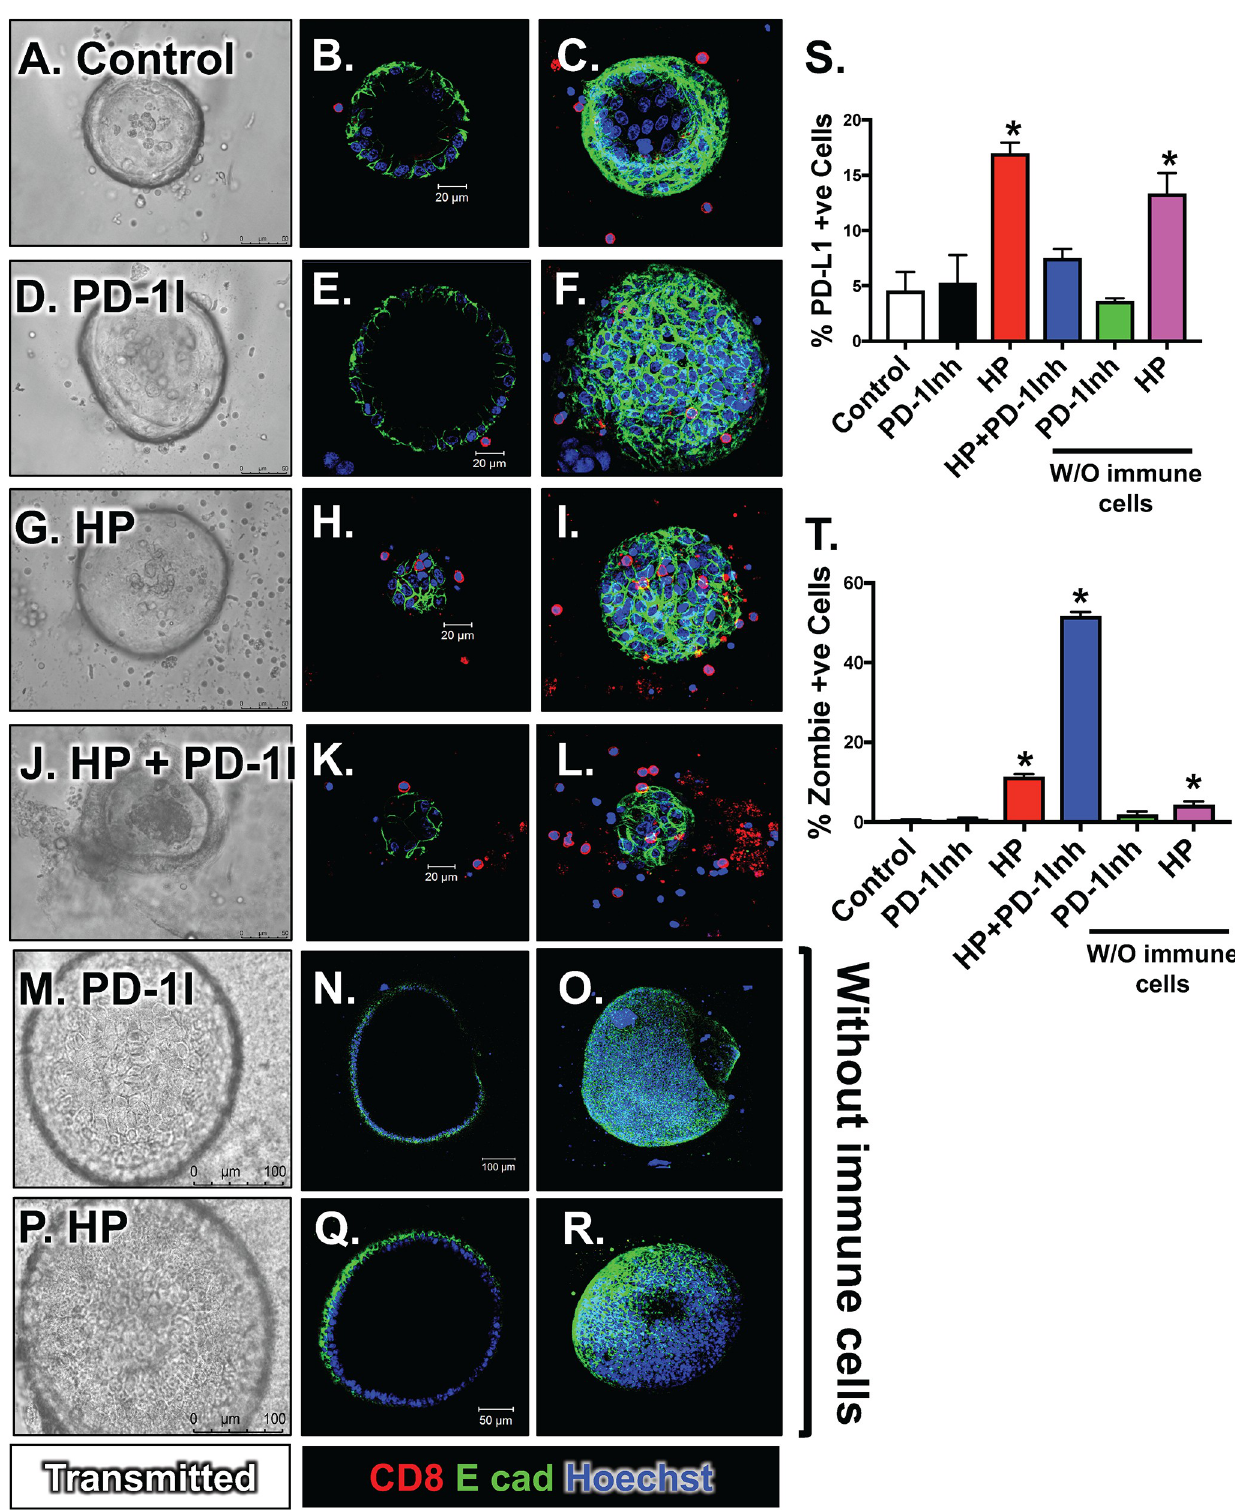
Fig 12. Changes in epithelial cell viability in human-derived organoid/immune cell co-cultures infected with H . pylori . Light micrographs, immunofluorescence staining for E cadherin (E cad, green) and CD8 (red), and flow cytometric dot plots for percentage of Zombie (dead) PD-L1+ve cells in (A-C) control, (D-F) PD-1Inh treated, (G-I) H . pylori (HP) infected, and (J-L) HP+PD-1Inh treated organoid/immune cell co-cultures, and (M-O) PD-